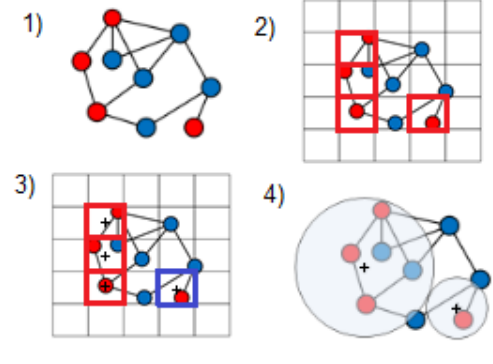
Fig. 5. Identification of POI and ROI.